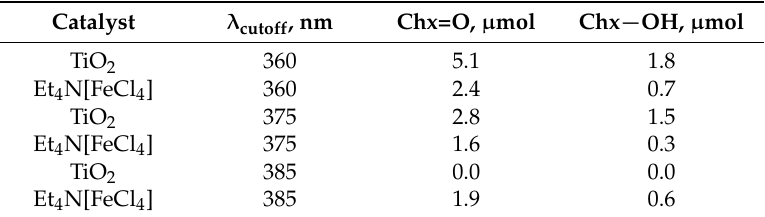
Table 13. Yield of cyclohexanone and cyclohexanol after a 40-min irradiation of 1 mL of C 6 H 12 (1% acetic acid) in the presence of 20 mg of TiO 2 or Et 4 N[FeCl 4 ] with a 100- W Hg lamp and a cutoff filter as